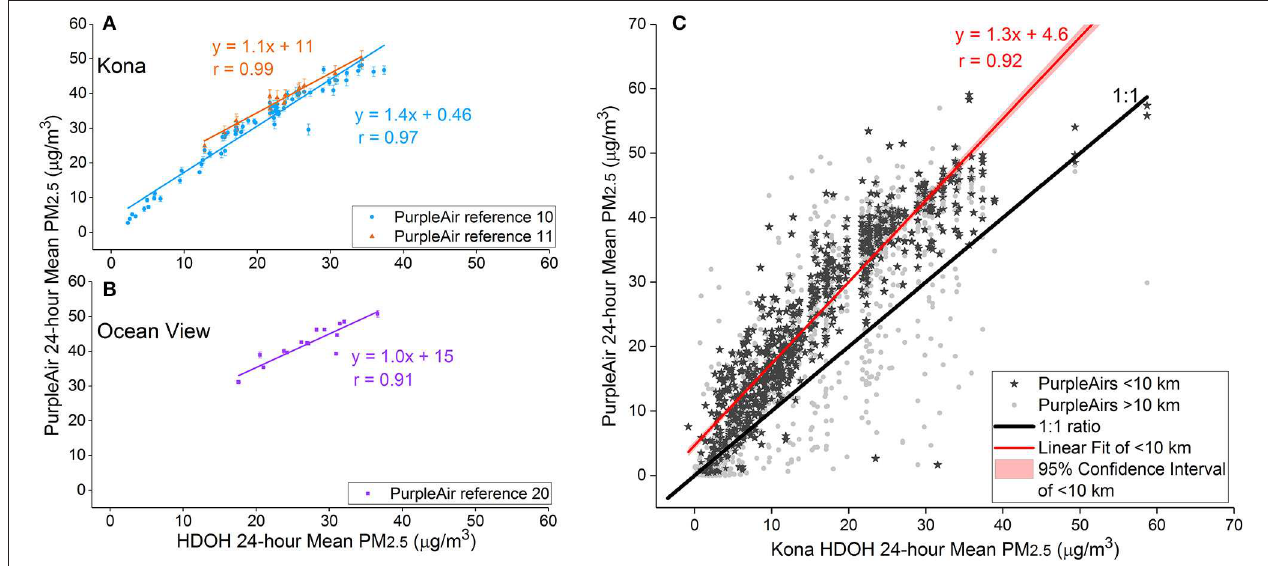
FIGURE 7 | PurpleAir and HDOH PM 2.5 comparison. (A) Two PurpleAir instruments co-located with Kona HDOH station. (B) One PurpleAir instrument co-located with Ocean View HDOH station. (C) Comparison of all PurpleAir instruments along the western region of the Island of Hawai’i compared with Kona HDOH measurements. PurpleAir instruments within 10 km of Kona HDOH indicated by dark gray stars, PurpleAir instruments at greater distances are indicated by light gray circles. Linear regression and 95 % confidence interval fit to instruments < 10 km from Kona HDOH ambient air quality station. Measurement periods vary with earliest PurpleAir data from August 2017 and most recent from January 2019. (A,B) PurpleAir error bars show measurement variations between the two sensors within a single PurpleAir instrument, and therefore indicate the minimum